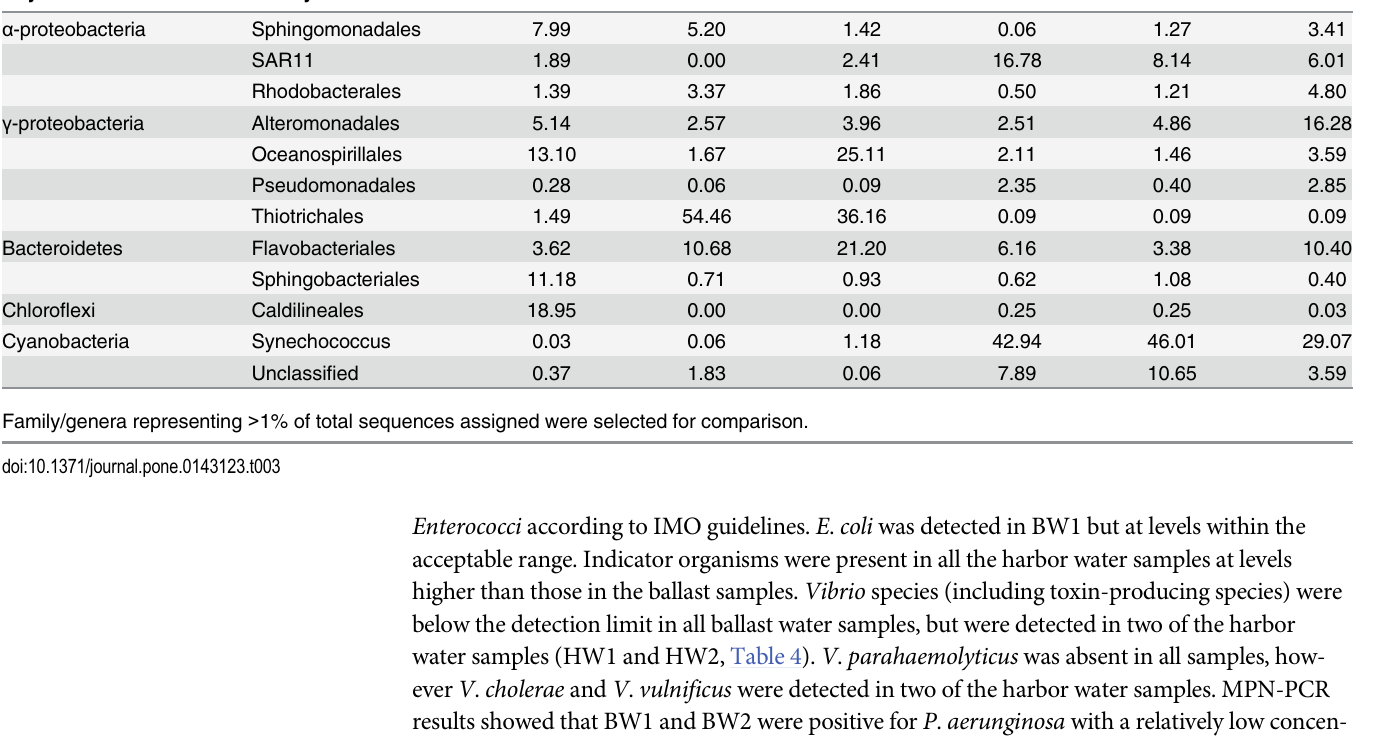
Table 3. Percentage of total sequences assigned to most dominant taxa. Data presented include the top 4 abundant phyla/classes across samples. Phyla/Class